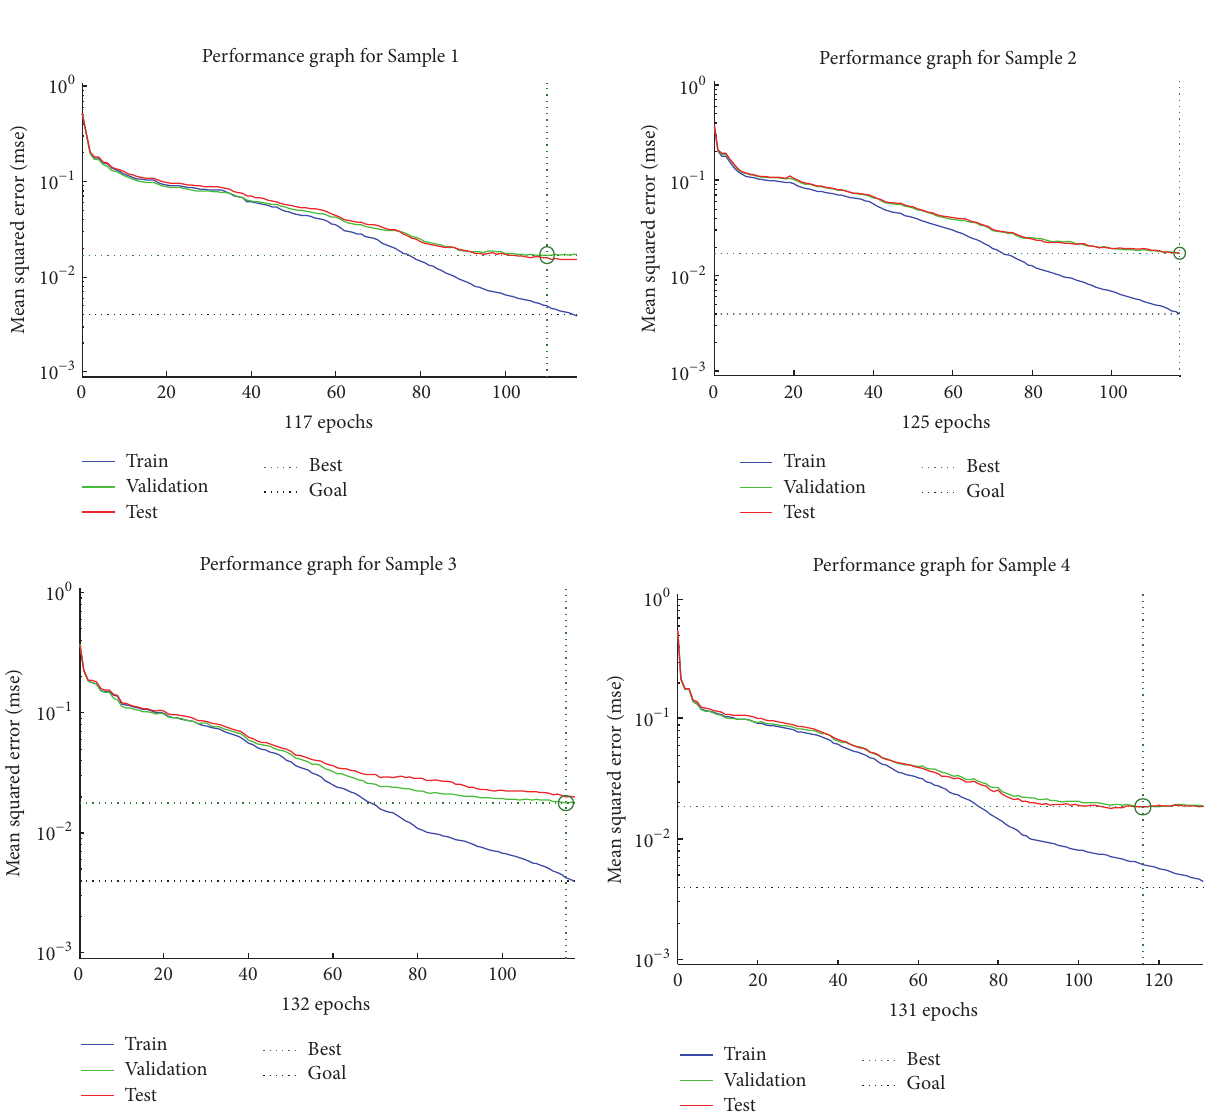
Figure 10: Performance graphs samples using [4 × 10 × 4] neural network